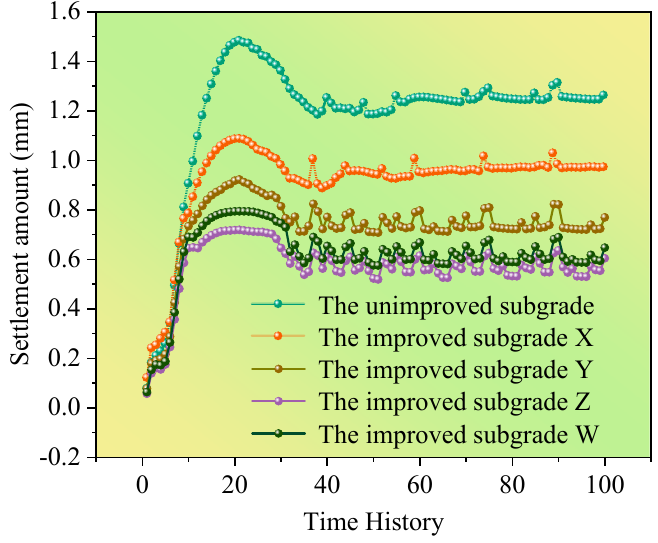
Figure 14. Time-history curve of subgrade settlement.